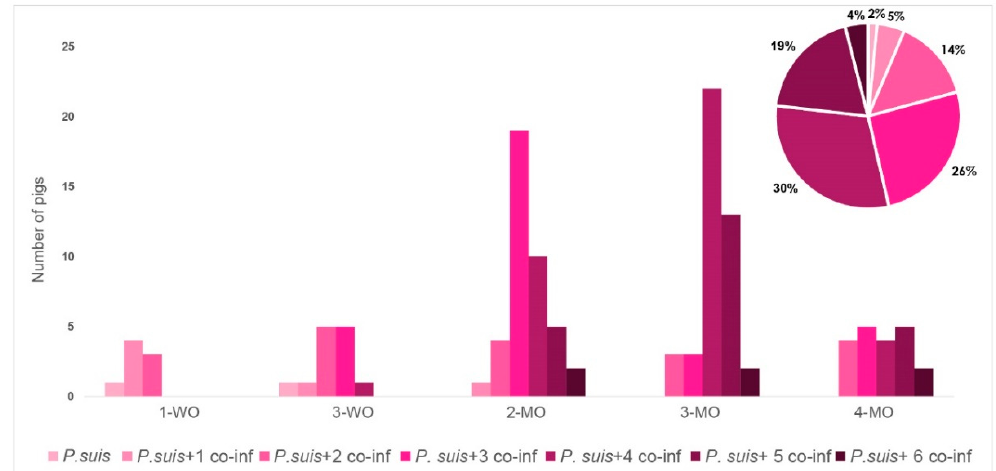
Figure 4. Prevalence of different P. suis co-infection combinations over time.